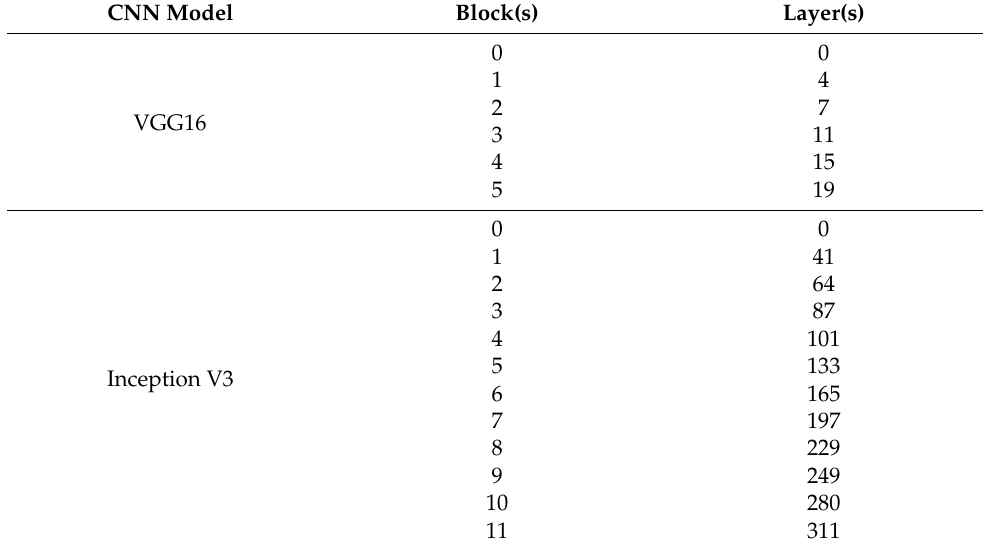
Table 10. VGG16 and Inception V3 networks.